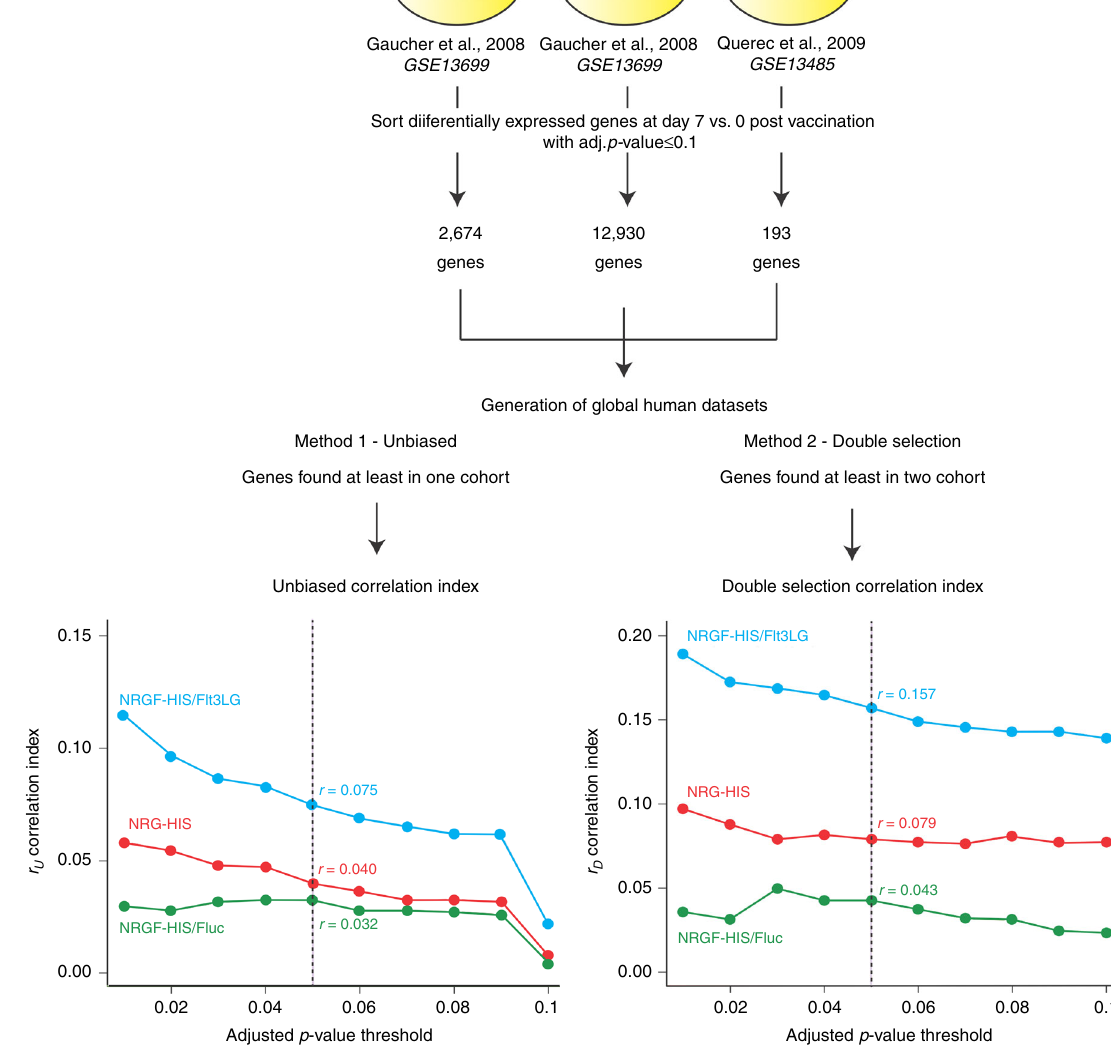
Fig. 5 Human-like transcriptomic response to YFV-17D infection in NRGF-HIS/Flt3LG. Differentially expressed genes from PBMCs of three YFV-17D human vaccinee cohorts (Lausanne, n = 11; Montreal, n = 15; Emory, n = 25) were used to generate two global human transcriptomic datasets: an unbiased dataset (all differentially expressed genes ( p adj ≤ 0.1) found in at least one cohort) and an double-selection dataset (all differentially expressed genes ( p adj ≤ 0.1) found in at least two cohorts). For a given human global dataset (unbiased, left; double selection, right) and p adj threshold (starting at p adj ≤ 0.1 with 0.01 increment), the Spearman rho correlation index was computed for each humanized mouse model transcriptomic dataset (NRG-HIS, NRGF-HIS/Fluc, and NRGF-HIS/Flt3LG) and plotted as function of the p adj threshold. The Spearman rho correlation index for the unbiased and double selection method are respectively referred as r U and r D . The de fi nitive correlation indexes for the unbiased and double selection method, referred as r U and r D at p adj = 0.05 ( r U, r D,q = 0.05 ) respectively, are indicated on each graph and for each humanized mouse model. See Methods for more q = 0.05 and